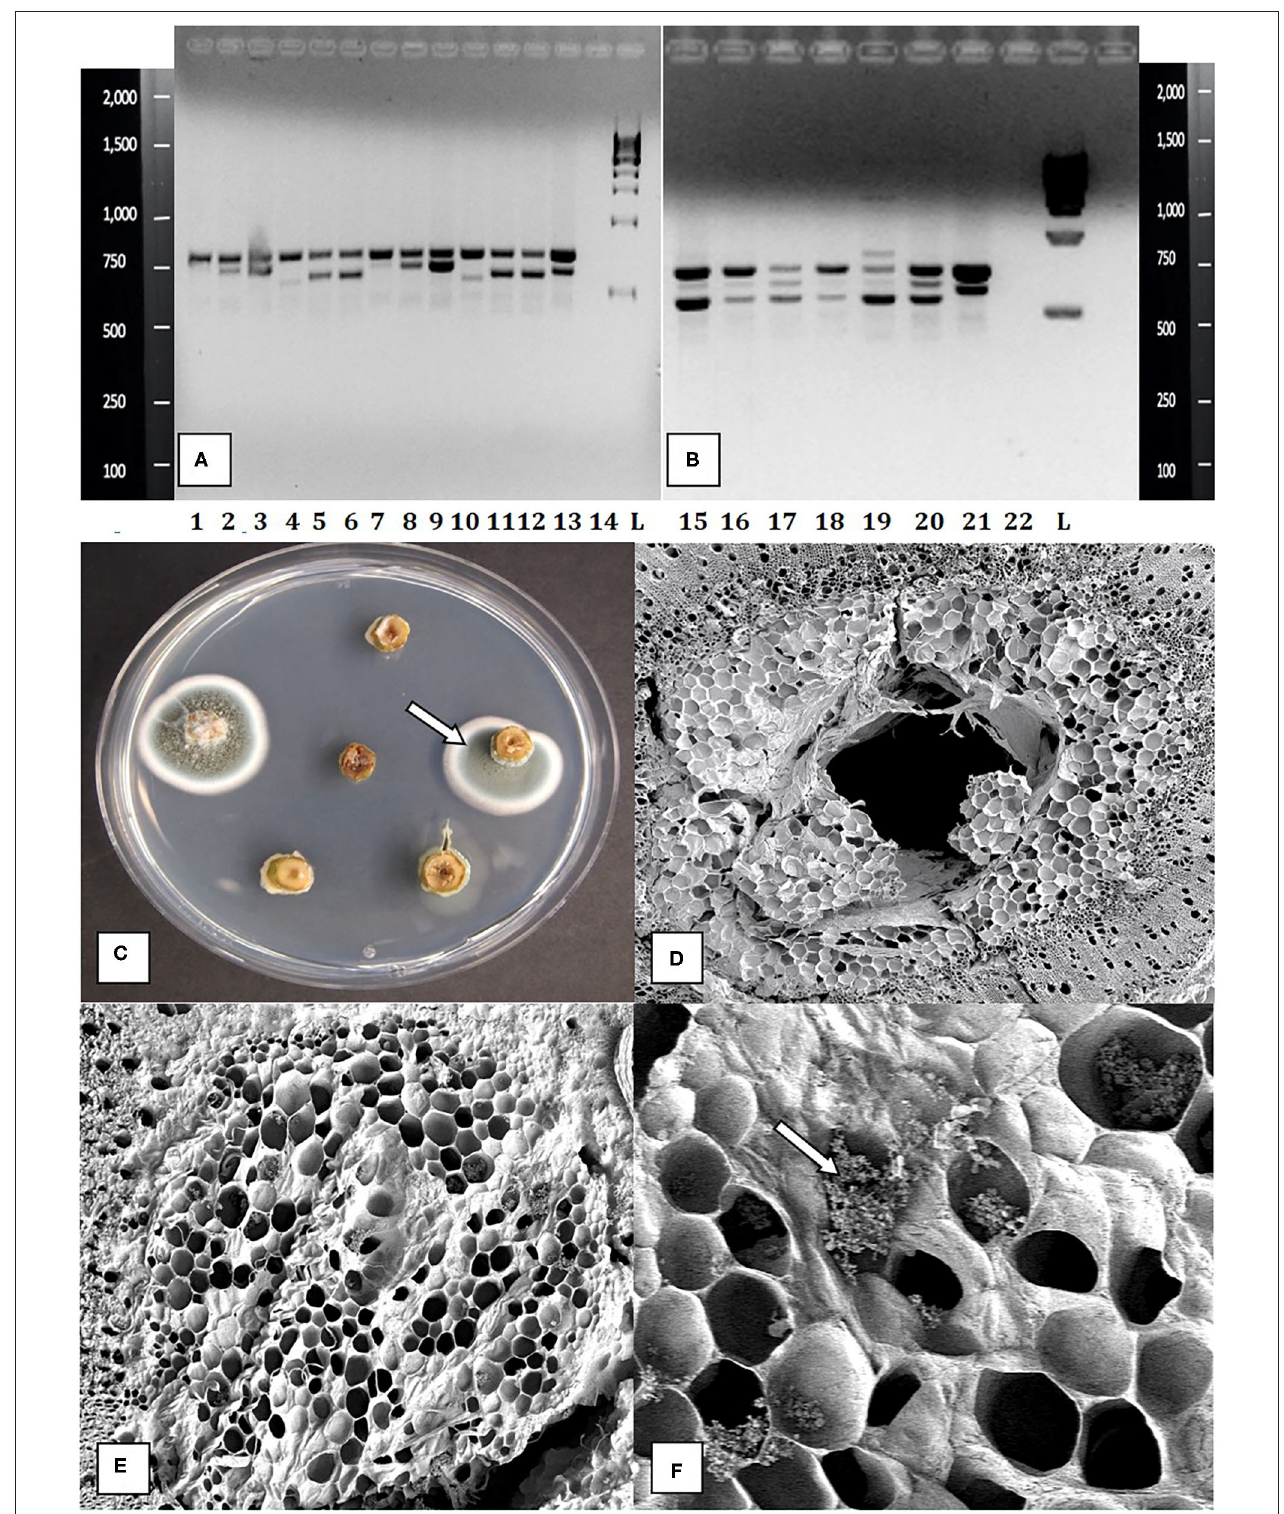
FIGURE 5 | Molecular detection and identification of tissue culture contaminants. (A,B) PCR detection of fungal DNA present in naturally contaminated nodal explants. Upper bands at 750 bp size are plant DNA. Lower bands at ca. 650 bp are fungal DNA. These bands were cut and sequenced to determine the corresponding fungus present. Lanes 1–13 (lower bands) are as follows: clean, Simplicillium lasoniveum , Trichoderma harzianum . Clean, Beauveria bassiana ,